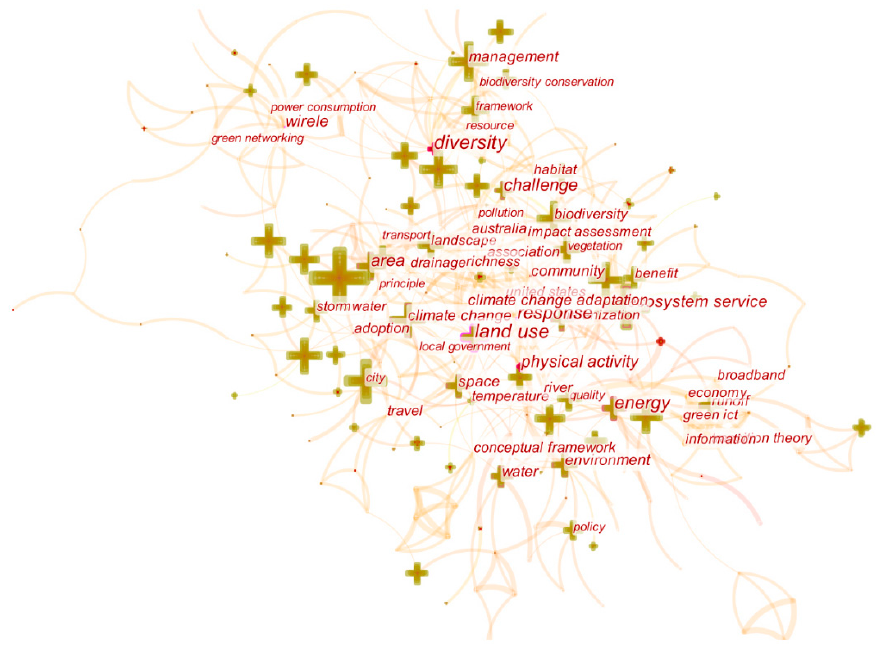
Figure 4. Distribution of top 50 keywords. Table 1. Top 30 most frequently used keywords during 1990–2020.